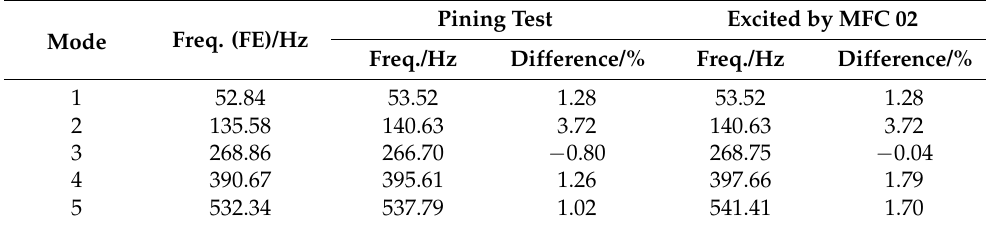
Table 2. Test frequency and FE simulation